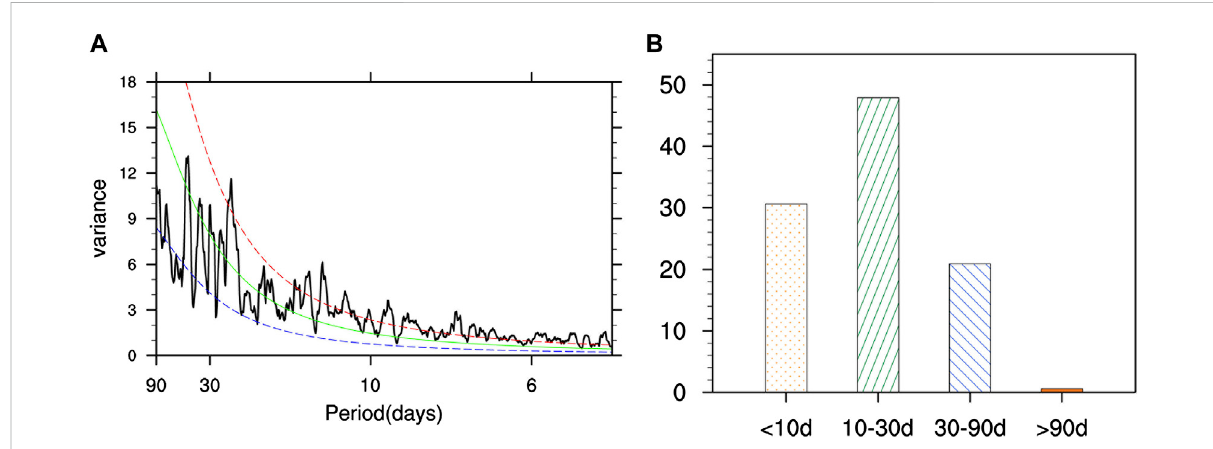
FIGURE 9 Same as Figure 4. (A) the power spectrum analysis and (B) variation contributions over the low-latitude key region.